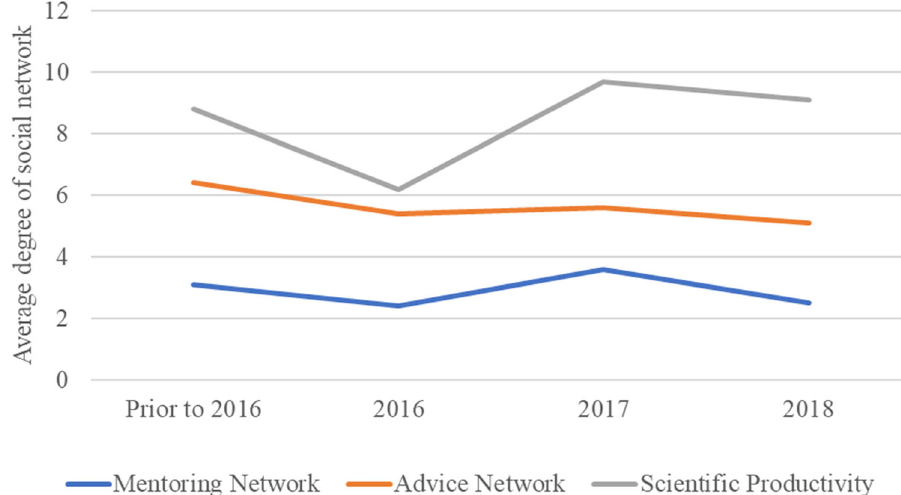
Fig. 4 Robust patterns of collaboration over time. Average degree of social networks diagrams (mentoring, advice, scienti fi c productivity) indicated strong social ties among team members.